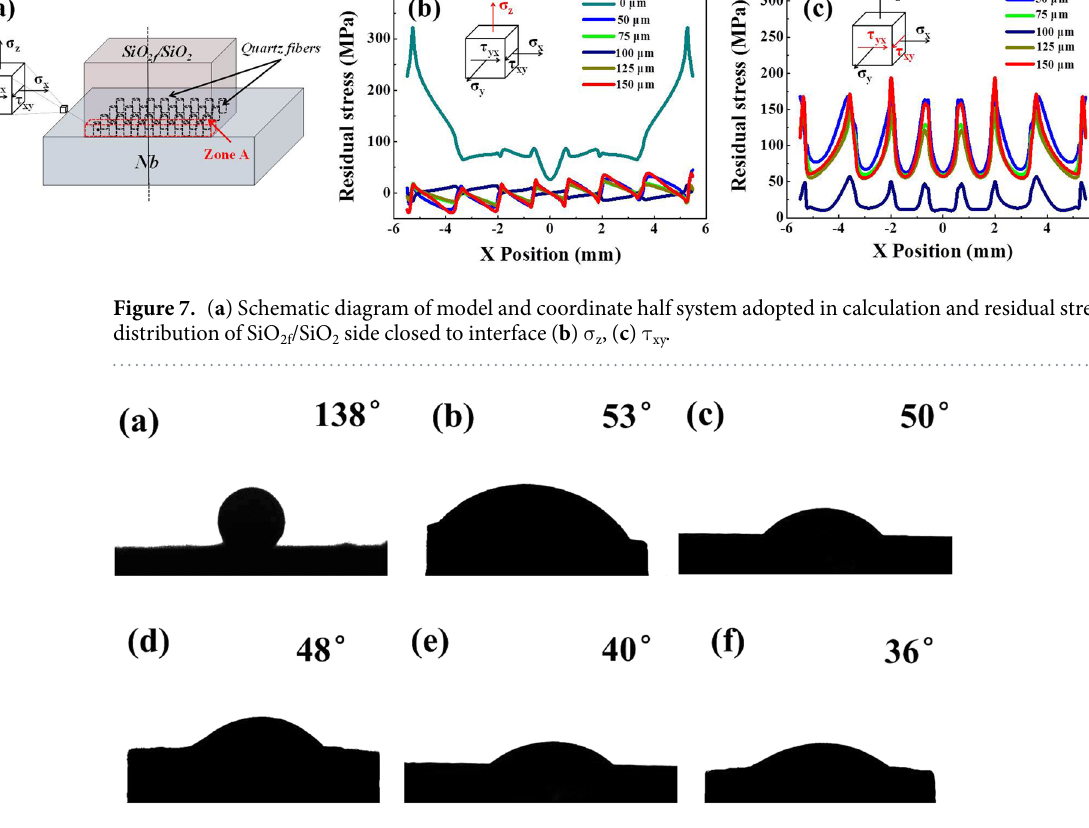
Figure 8. Contact angles of AgCuTi brazing alloy on the ( a ) 0 μ m@E-SiO 2f /SiO 2 , ( b ) 50 μ m@E-SiO 2f /SiO 2 , ( c ) 75 μ